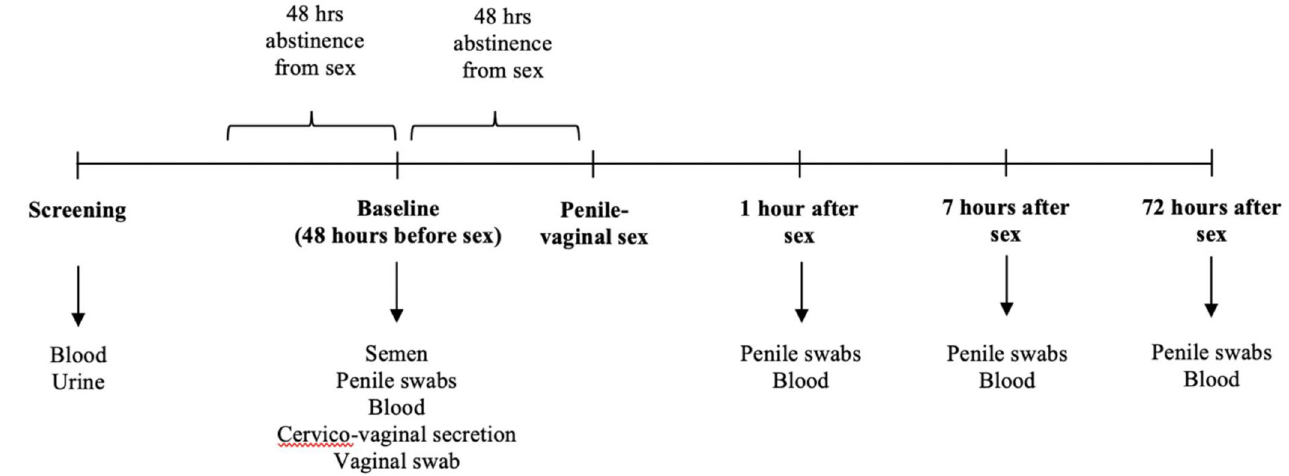
Fig 1. Overview of the study protocol. Diagrammatic illustration of the study protocol. Arrows indicate samples collected at specific study visits.